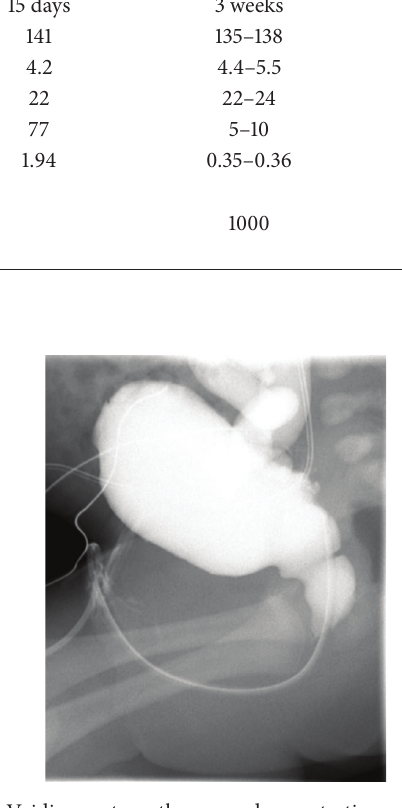
Figure 1: Voiding cystourethrogram demonstrating a thick-walled, trabeculated bladder with an enlarged posterior urethra that is consistent with posterior urethral